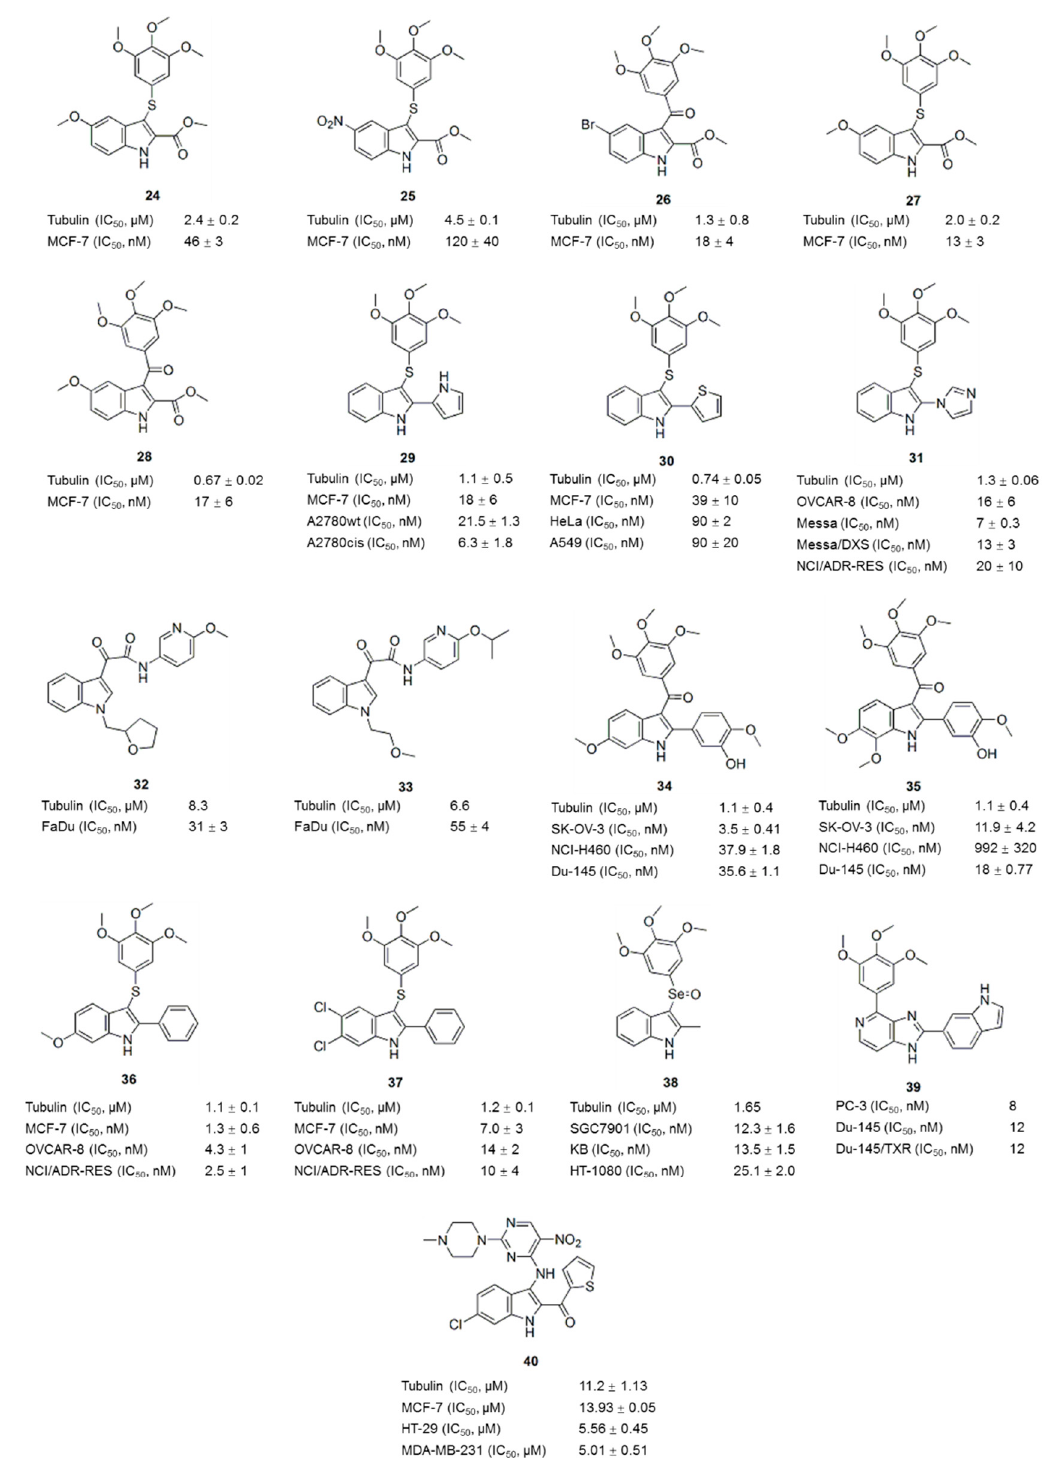
Figure 5. Arylthioindole derivatives and other indole-based compounds.